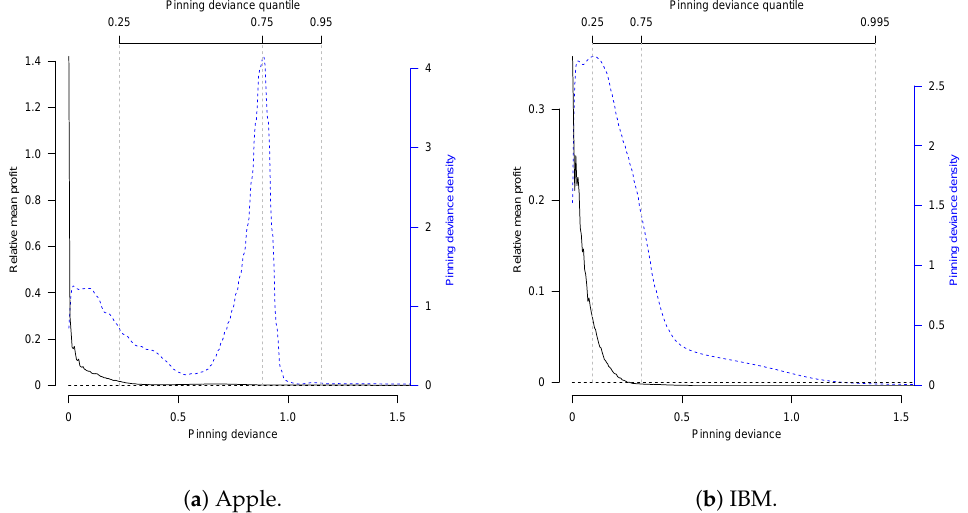
Figure 7. Results of the real data application. The black curve is the relative mean profit ( BB ( p ) GBM ( p )) /GBM ( p ) for a pinning deviance p , while the blue dashed curve represents the − kernel density estimation of the pinning